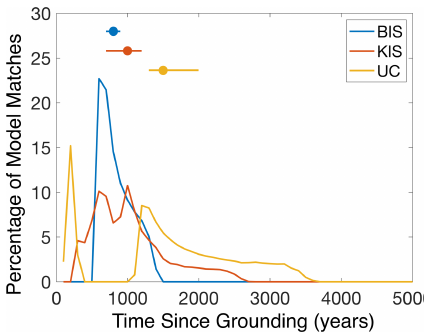
Figure 5. Results of temperature diffusion modeling. The y axis represents the frequency at which the modeled basal temperature gradients fit within 10% of the observed basal temperature gradi- ents (Engelhardt, 2004). The number of observed basal temperature gradients varied between the sites: one observation for BIS, four observations for KIS, and three observations for UC. The dots and lines in the upper portion of the figure correspond to the median and the 32nd to 68th percentiles of the distributions shown in the lower portion of the figure. The total number of model runs performed was 808000, corresponding to a time window of 8000 years ago to present.